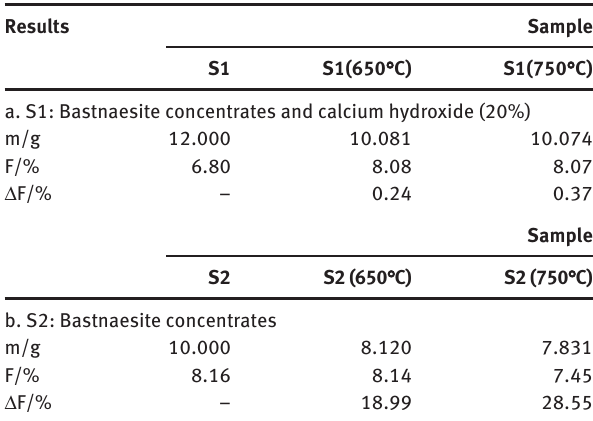
Table 2: Emission rate of fluorine in roasting process.